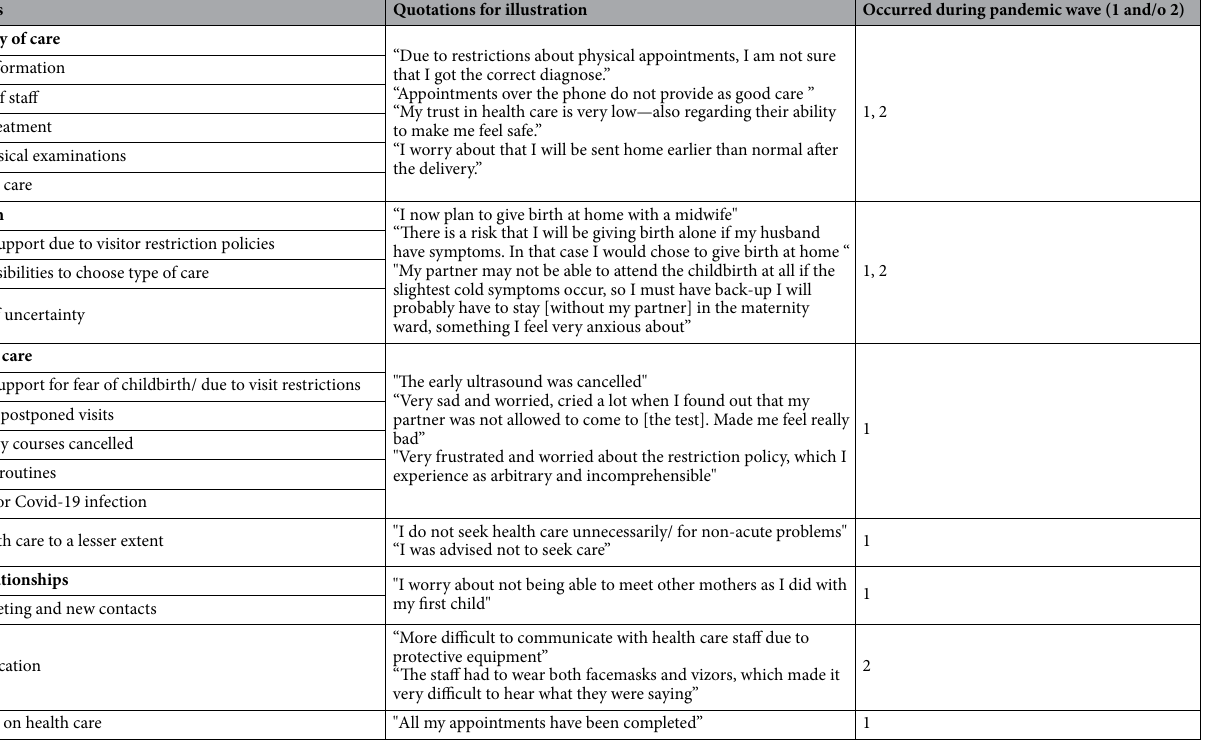
Table 3. Categorization of participants’ experiences of how maternity care was affected during the two first waves of the